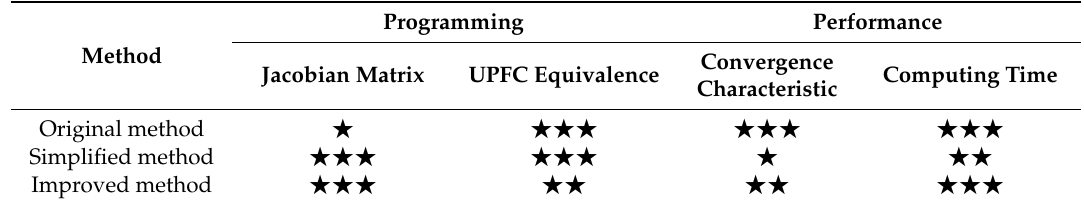
Table 5. Comparison of the proposed methods. “ (cid:70) ” is used to score methods, the method with more stars ( (cid:70) ) is